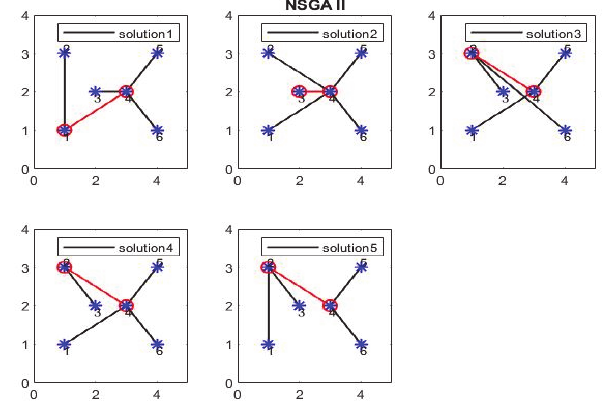
Fig. 9 . How to assign non-hub nodes to hub nodes in problem solving with NSGA II